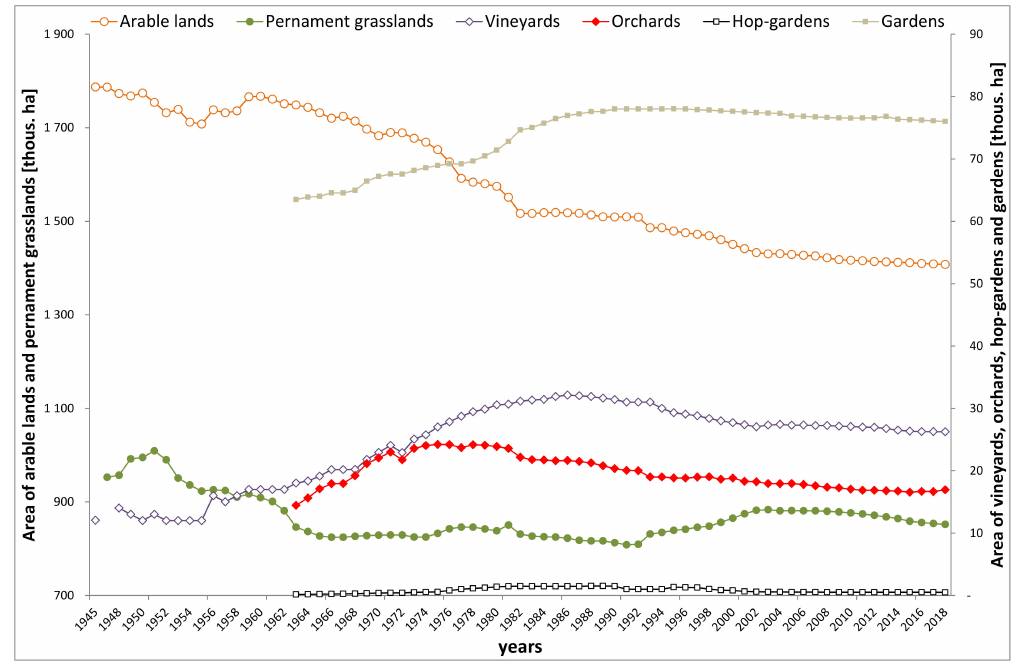
Figure 1. Area evolution of agricultural land use types in Slovakia